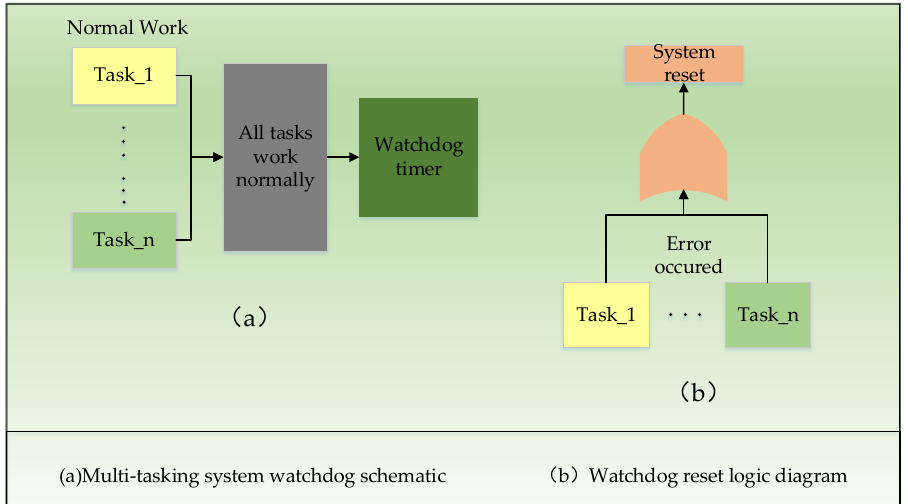
Figure 6. The operational process of the watchdog within the system, which is applied to the main board of the LoRa acquisition equipment in order to ensure the device works